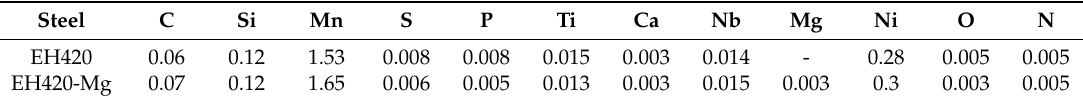
Table 1. Chemical composition of experimental steel in wt